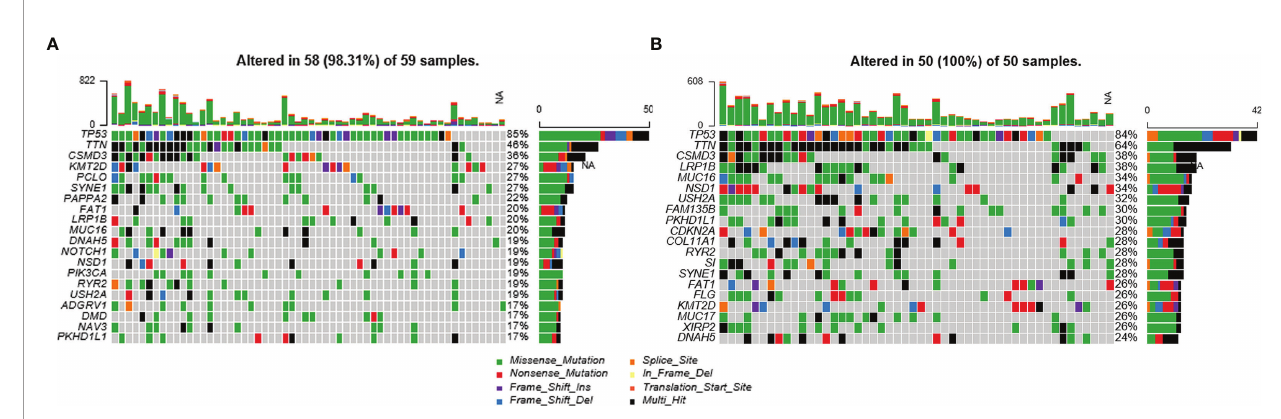
FIGURE 2 | Mutation status of LSCC patients with different immune-in fi ltration phenotypes in the TCGA cohort. (A) Patients with high-in fi ltration phenotype. (B) Patients with low-in fi ltration phenotype. NA, Not Available.